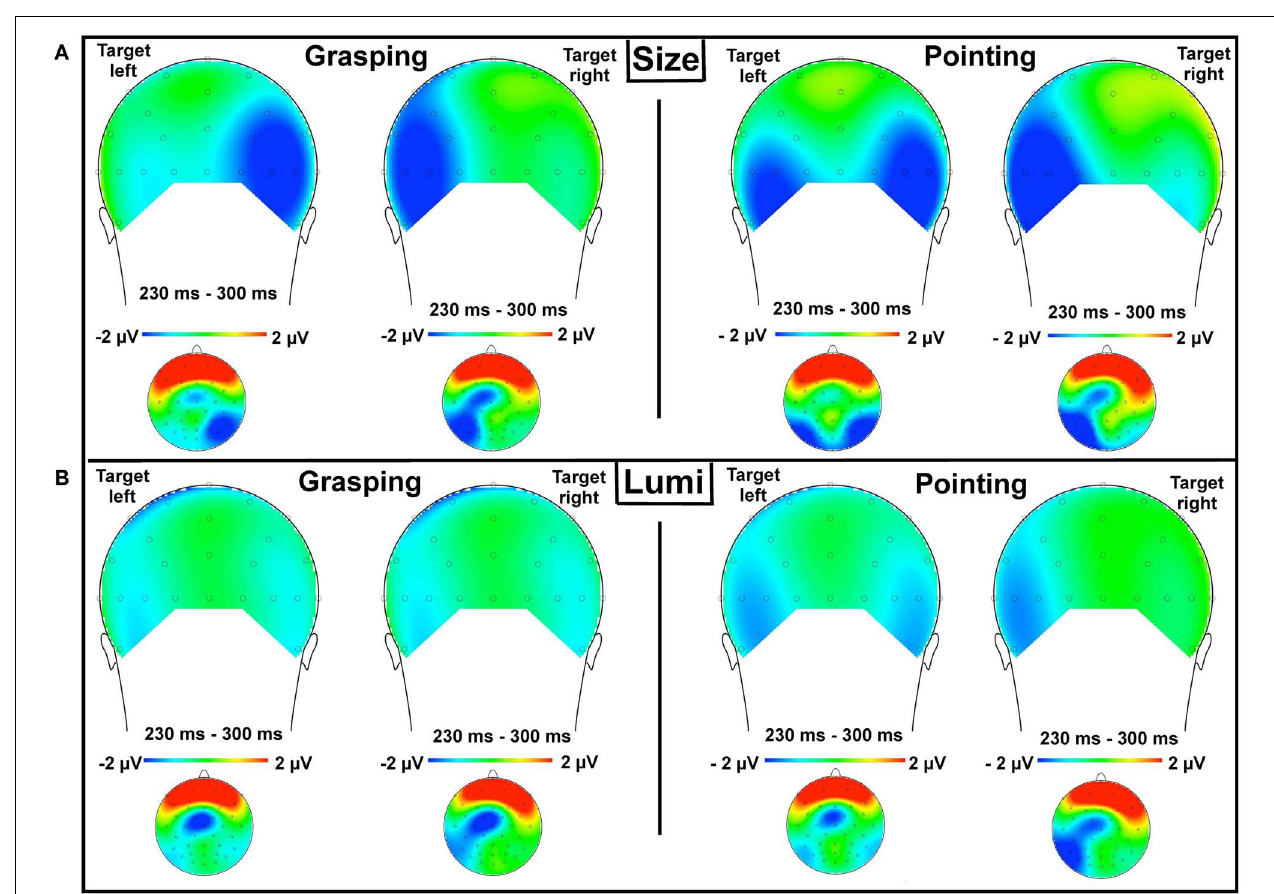
for the left size targets in the pointing condition [ (A) , right] might be a slight indication of not entirely successful disengagement of attention from the right visual hemifield when targets were presented on the left.This may have resulted from the pointing cue that may have acted as a directional cue to the right hemifield.This effect, however, needs to be taken with caution, as it has not been supported by the behavioral results, see Appendix. In the luminance condition (B) , negativity was less pronounced in the grasping condition compared to pointing. In grasping trials, there was no difference in negativity for contra- and ipsilateral sites (B) , left) yet a slight difference is observed in the pointing condition for target presented in the right hemifield [ (B) ,